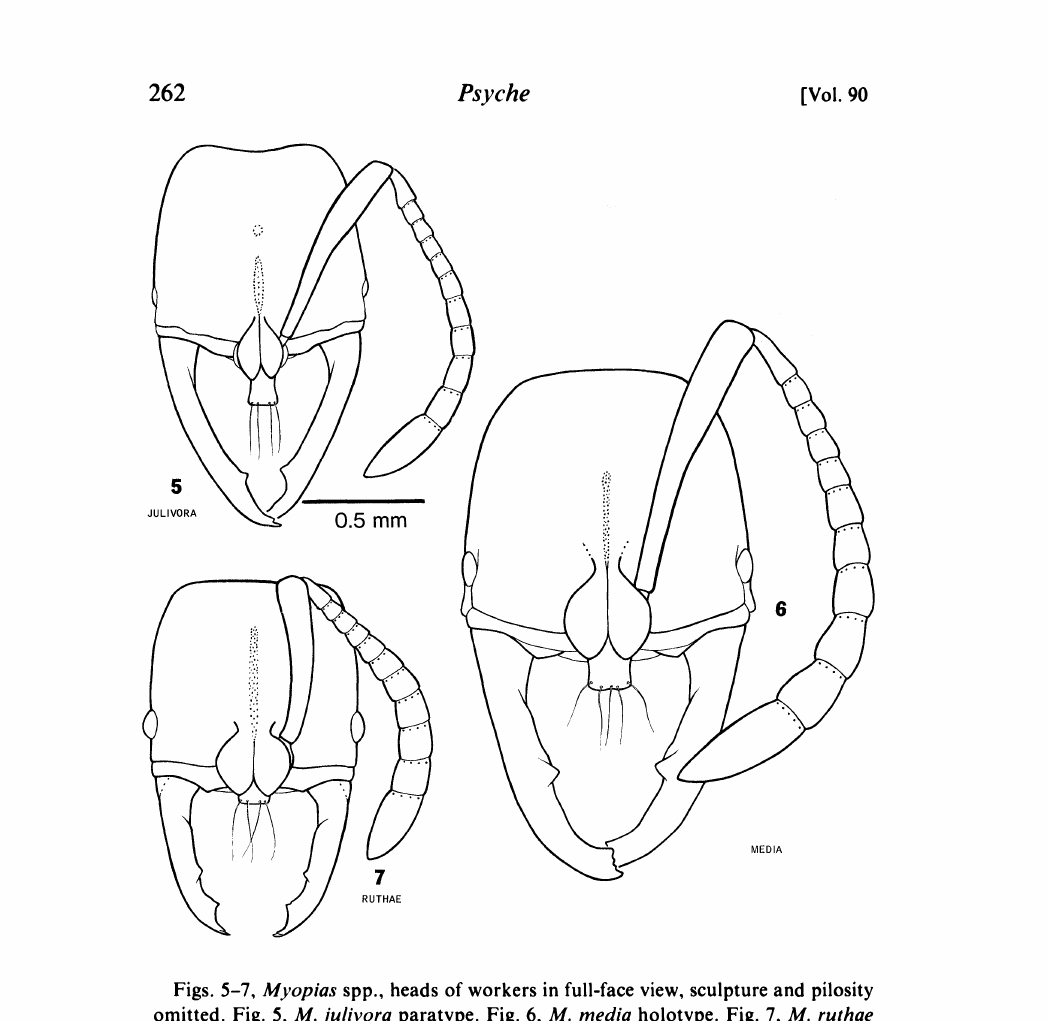
Figs. 5-7, Myopias spp., heads of workers in full-face view, sculpture and pilosity omitted. Fig. 5, M. julivora paratype. Fig. 6, M. media holotype. Fig. 7, M. ruthae holotype, All to same scale; bar is 0.5